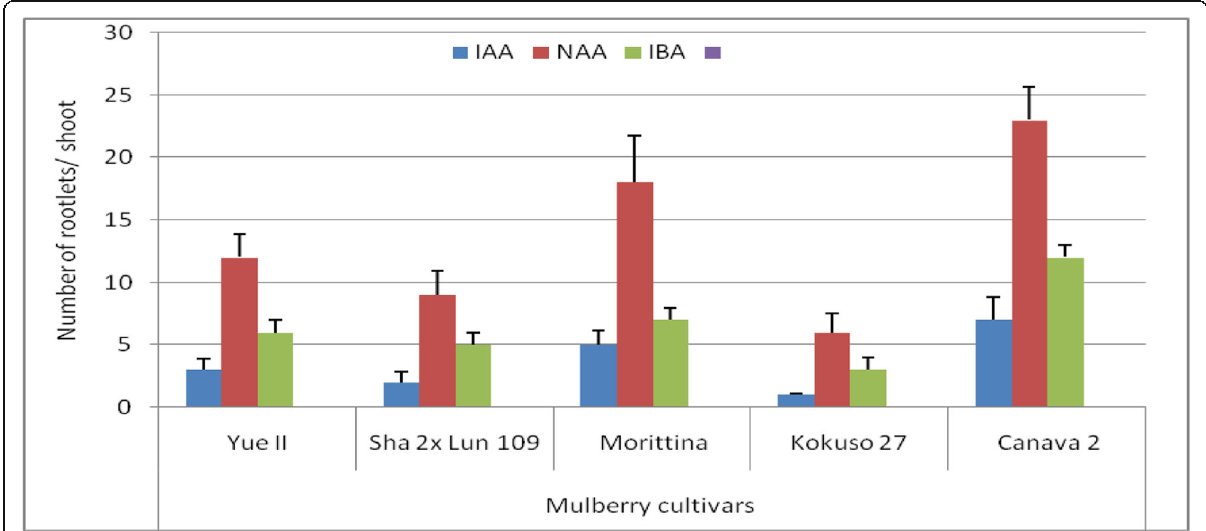
Fig. 4 Effect of the MS medium supplemented with 1 mg/ of IAA, NAA, or IBA on the number of in vitro root formation on different mulberry